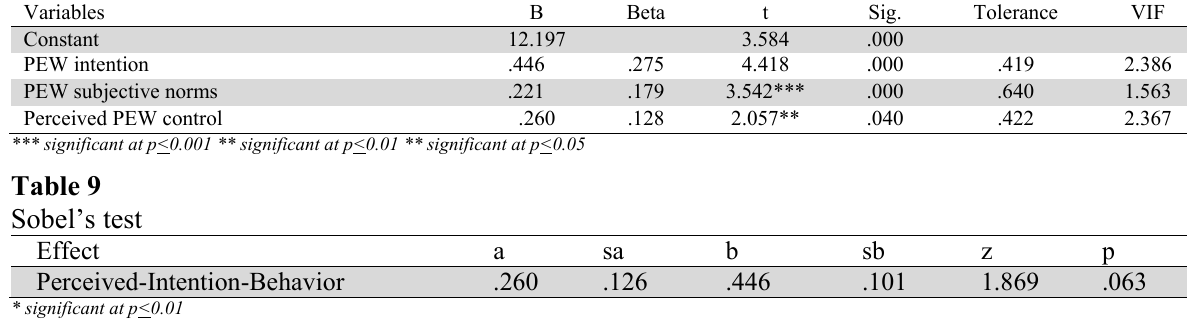
Mediated regression for PEW behavior Variables